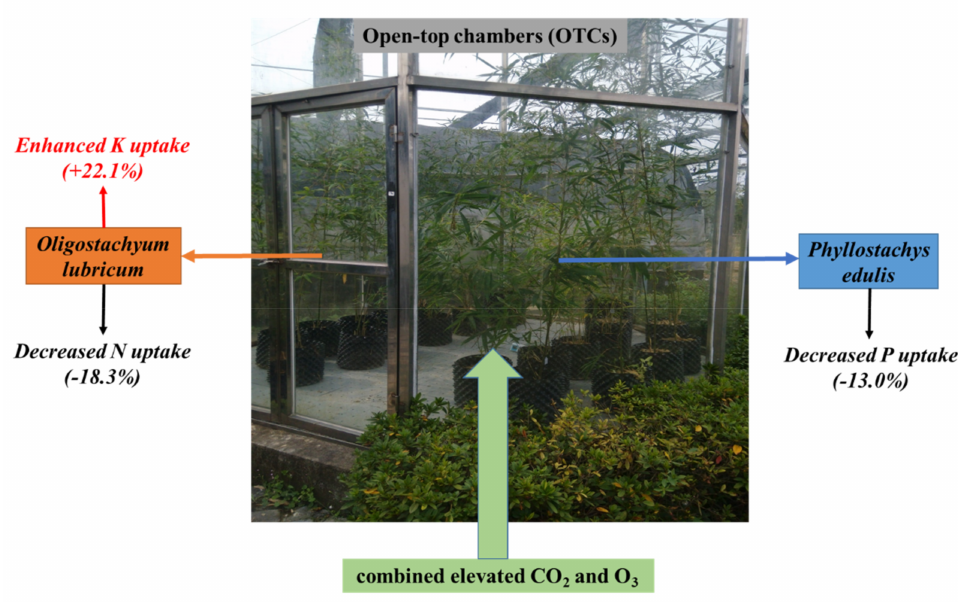
Figure 2. SignificantchangeinPuptakeof Phyllostachysedulis andNandKuptakeof Oligostachyumlubricum under combined elevated O 3 and CO 2